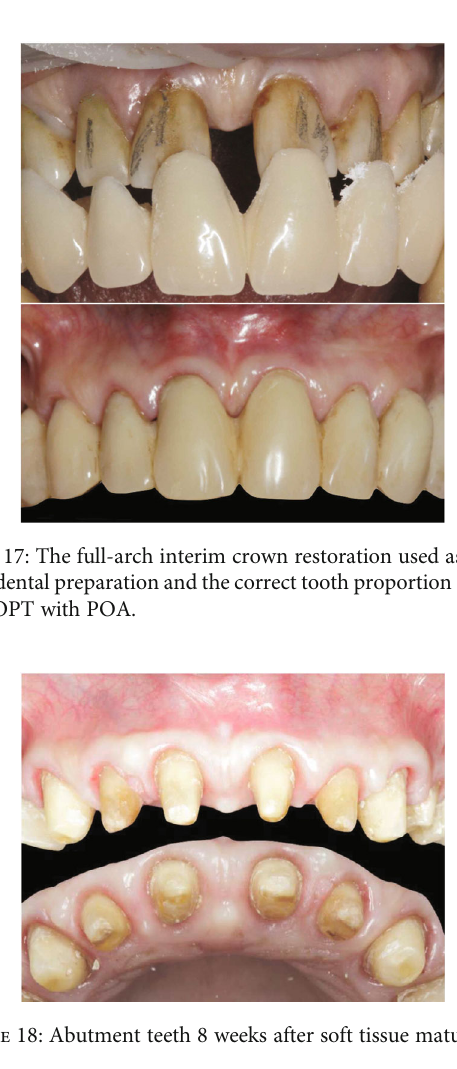
Figure 16: Preoperative extraoral and intraoral views showing 6 mm midline diastema.